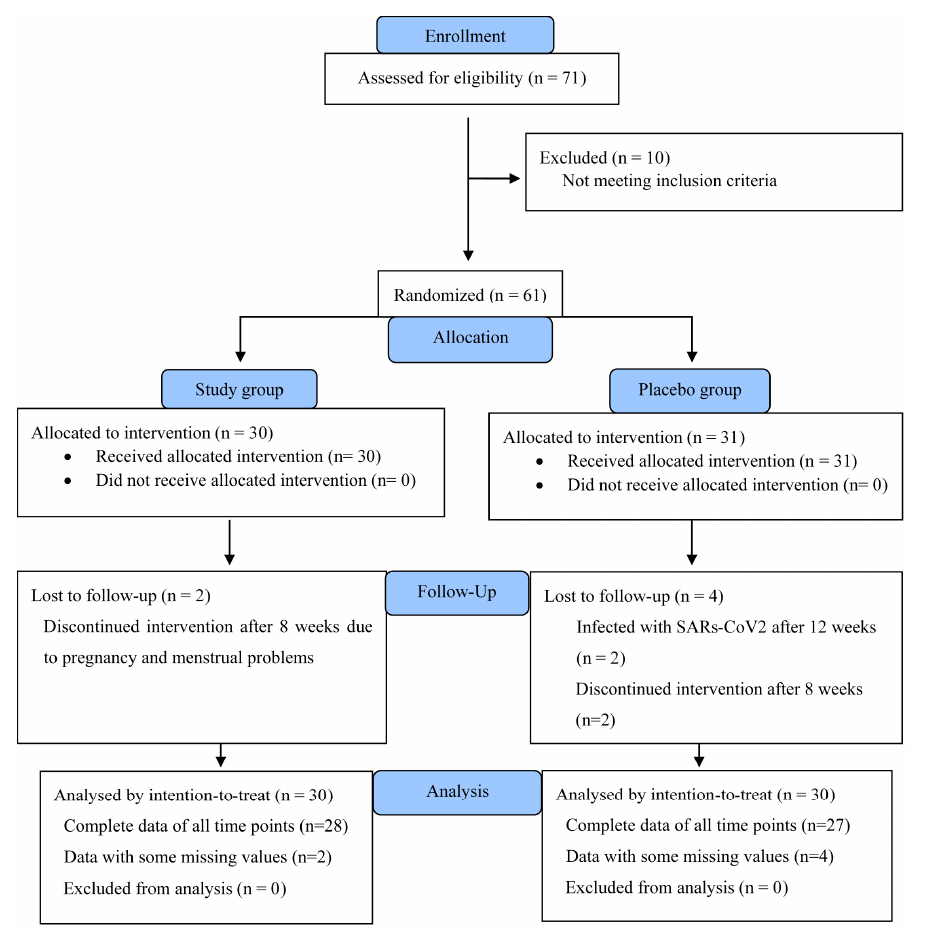
Figure 2. CONSORT participant flowchart. Table 1. Demographic characteristics of the participants at